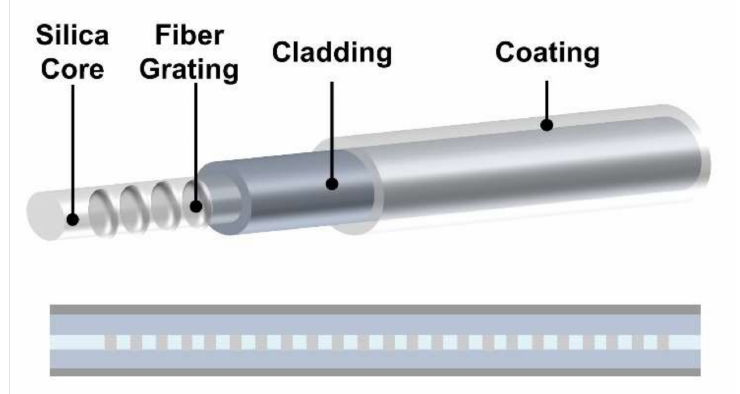
Figure 5. Schematic of fiber grating for radiation-induced wavelength shifting